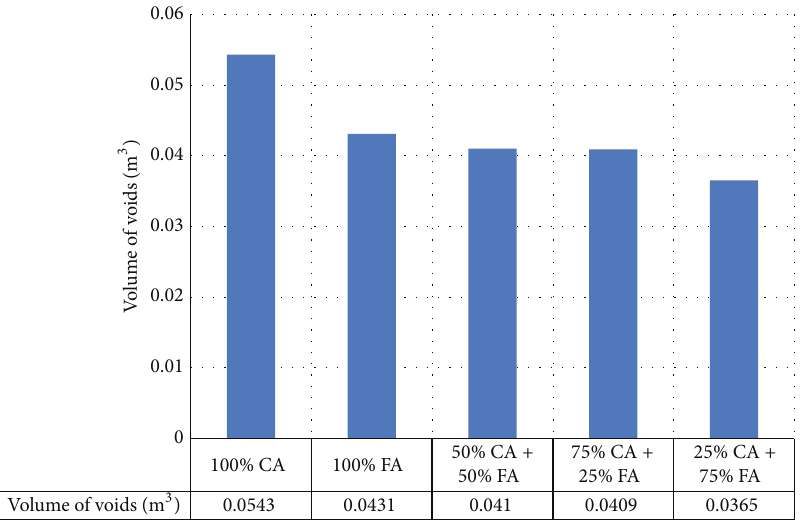
Figure 4: Volume of voids calculated from particle packing.